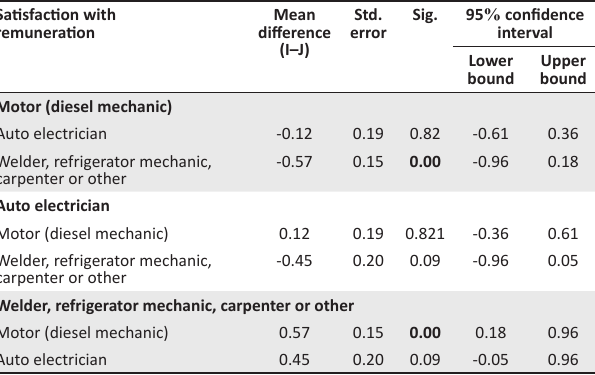
TABLE 3: Multiple comparison tests between the mustering codes groups (post hoc). Satisfaction with remuneration